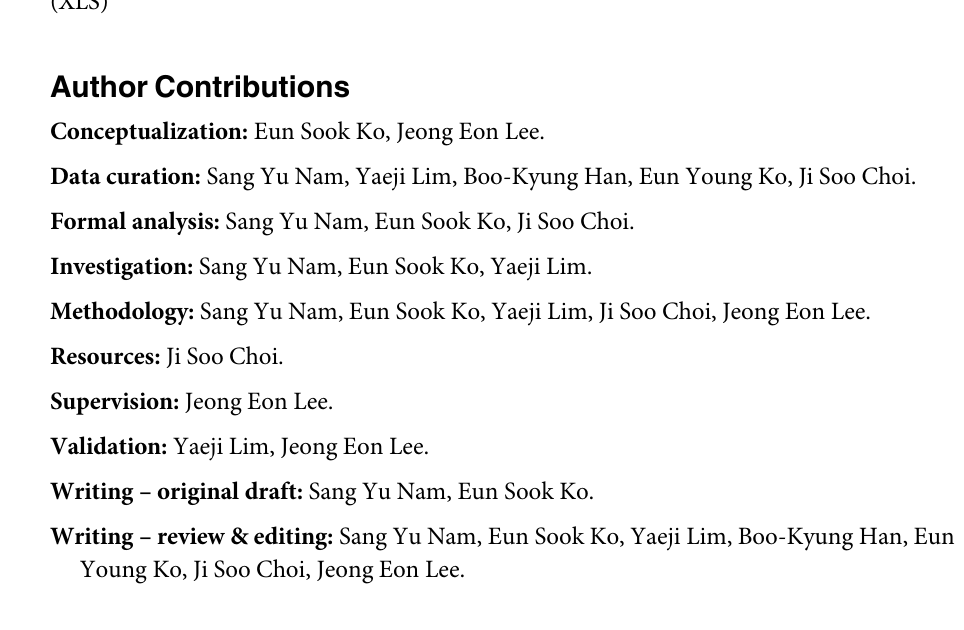
S1 Dataset. Detailed characteristics of